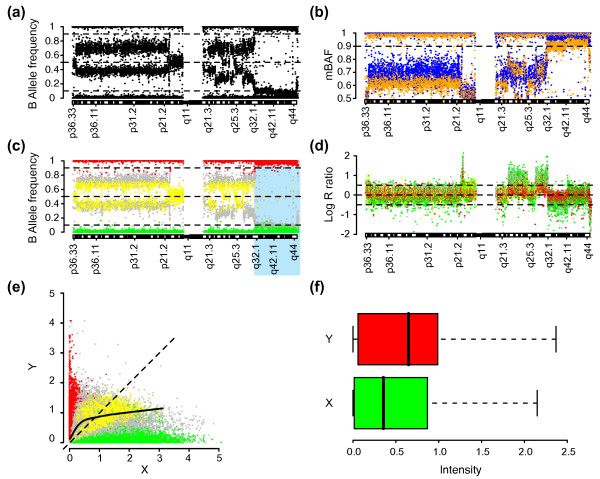
Occurrence of asymmetrical B allele frequencies and copy number estimates. Urothelial tumor UC152_I hybridized on an Infinium 370 k BeadChip is shown. CNV probes have been removed. (a) B allele frequency for chromosome 1. (b)Mirrored B allele frequency (mBAF) for chromosome 1, with individual SNPs colored according to BAF values: less than 0.5 (orange), above 0.5 (blue) showing the asymmetry of BAF values around 0.5. (c) BAF profile of chromosome 1, with individual SNPs colored according to genotype calls: AA (green), AB (yellow), BB (red) and no calls (gray). The cause of the BAF asymmetry also affects genotyping as seen for SNPs not assigned to a genotype (gray), which in the region 1q32.1 to qter (highlighted with a light blue background) predominantly are present with BAF < 0.5. (d) Copy number estimates (Log R ratio) for chromosome 1, with individual SNPs colored according to genotype. The cause of the BAF asymmetry also affects copy number estimates as seen for regions of gain and loss, where AA and BB SNPs do not overlap. (e)  Scatter plot of normalized allele intensities X and Y with individual SNPs colored according to genotype. A lowess regression line (solid) for heterozygous SNPs and the expected X = Y line (dashed) are superimposed. (f) Boxplots of the distributions of allele intensities X (green) and Y (red).